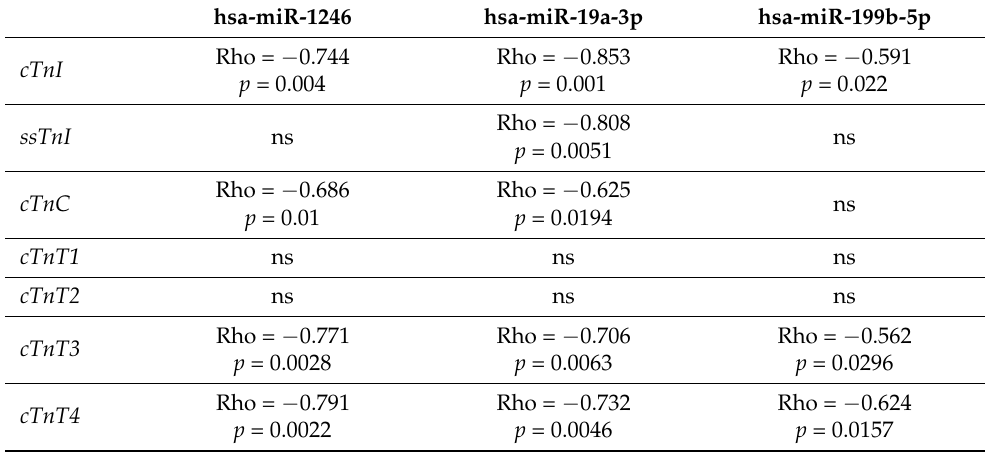
Table 3. Relation among cardiac miRNA and cardiac troponin expression levels in HF children supported by